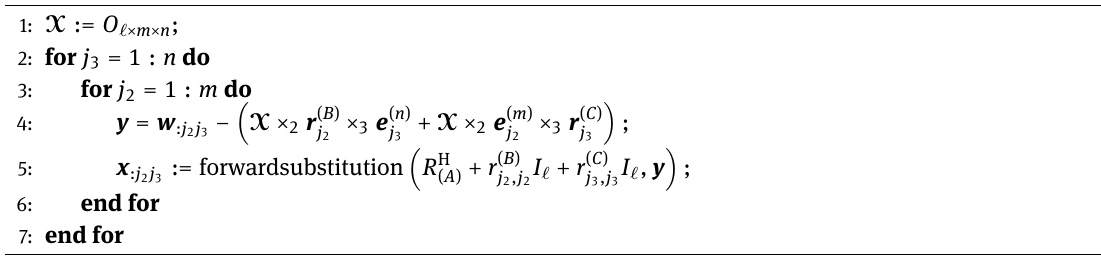
Algorithm 4-2(B) The forward substitution over tensor space for X = vec −1 (( R −1